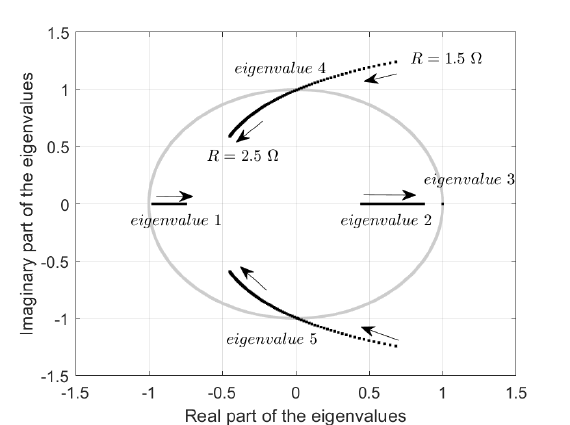
Figure 6. Locus of the eigenvalues of the monodromy matrix with R variations under healthy conditions h 1 = h 2 = h 3 =